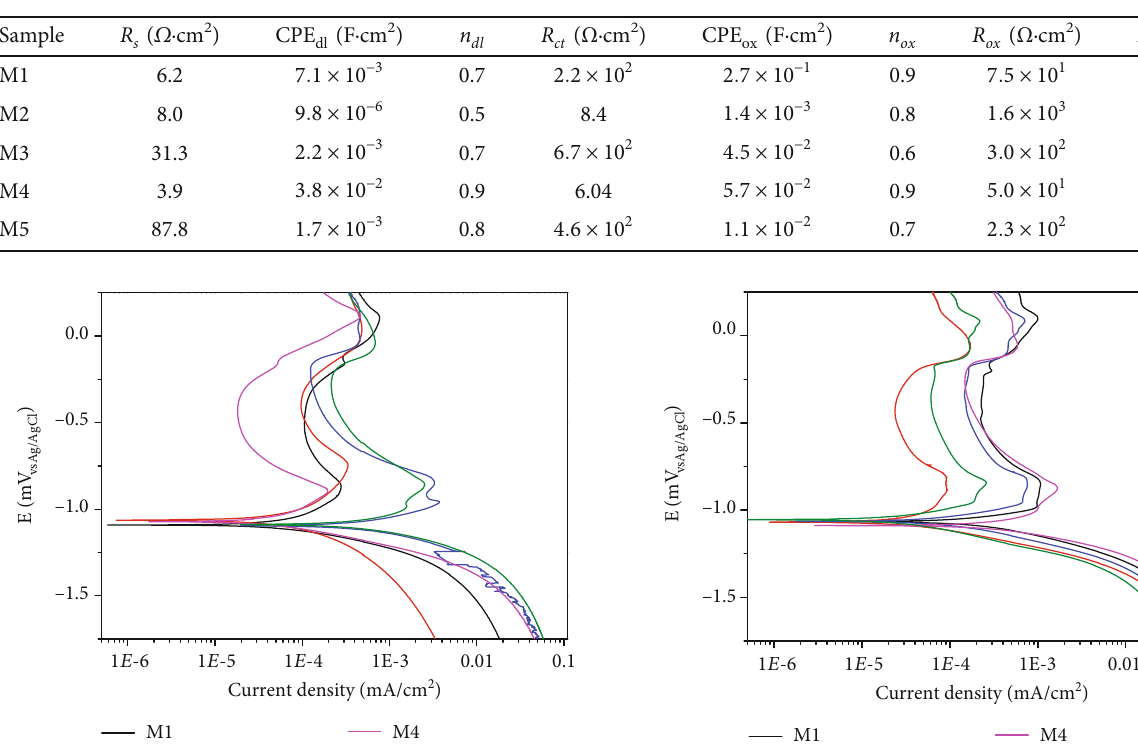
Table 4: Impedance parameters obtained through the equivalent circuit for aluminum-based alloy doped with Mn and Co after heat treatment at 1100 ° C heat treatment immersed in 3 M KOH.